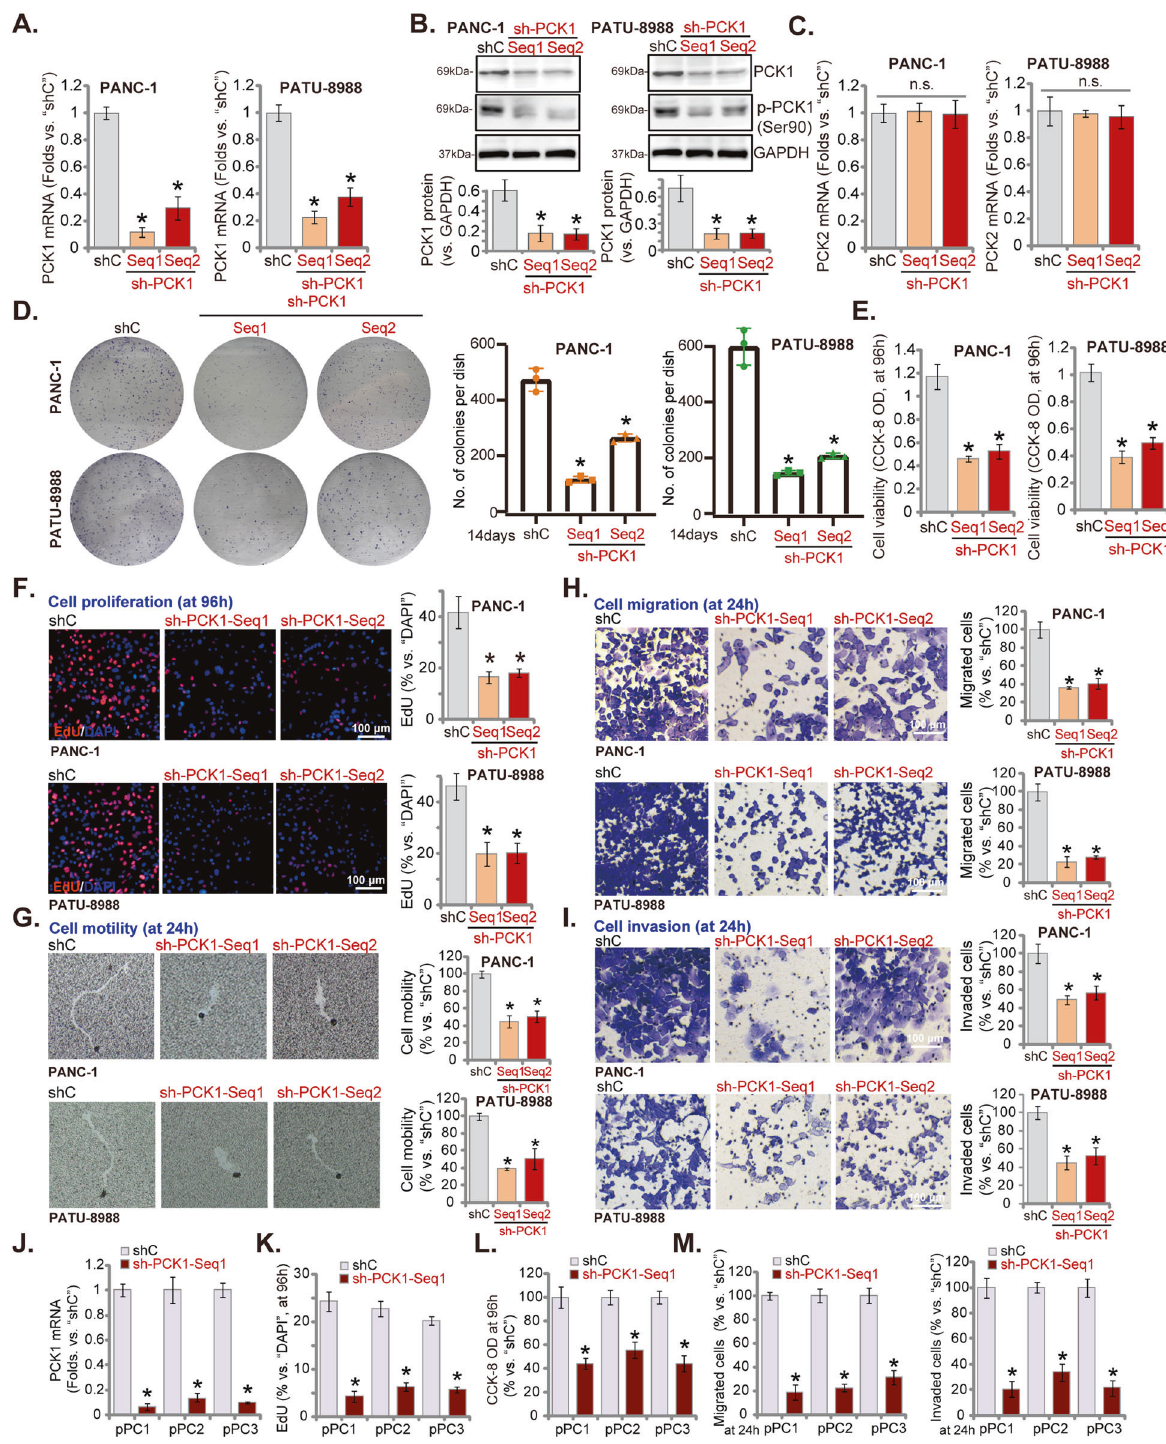
Fig. 2 PCK1 silencing inhibits pancreatic cancer cell growth, proliferation, and motility. Established human pancreatic cancer cell lines (PANC-1 and PATU-8988) ( A – I ) or primary pancreatic cancer cells ( “ pPC1/2/3 ” ) ( J – M ), bearing the PCK1 shRNA ( “ sh-PCK1-Seq1 ” or “ sh-PCK1- Seq2 ” ) or lentiviral scramble control shRNA ( “ shC ” ), were established. Expressions of PCK1 mRNA ( A , J ) and protein ( B ), as well as PCK2 mRNA ( C ) were shown; Cells were further cultured for applied time periods, colony formation ( D ), proliferation ( F , K ), viability ( E , L ), cell motility ( G ), cell migration and invasion ( H , I , M ) were tested by the listed assays mentioned in the text, with results quanti fi ed. For all EdU assays, fi ve random views of total 2500 cell nuclei per treatment were included to calculate the average EdU ratio (% vs. DAPI). For all “ Transwell ” and “ Matrigel Transwell ” assays, fi ve random microscopy views of each condition were included to calculate the average number of migrated/ invaded cells. For all in vitro cellular functional studies, exact same number of viable cells with the applied genetic modi fi cations was initially seeded ( “ Day-0 ” / “ 0 h ” ), and cells were cultured for applied time periods. Data were presented as mean ± standard deviation (SD, n = 5). * P < 0.05 vs. “ shC ” cells. “ n.s. ” stands for non-statistical difference ( C ). The experiments were repeated fi ve times with similar results obtained. Scale bar = 100 μ m ( F – I